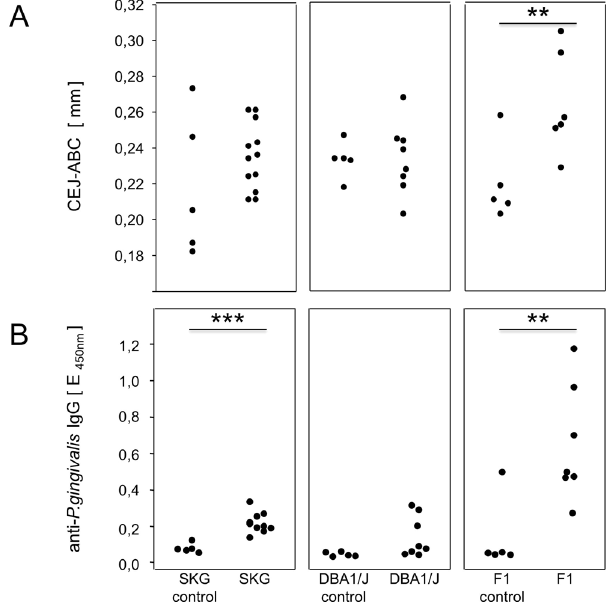
Figure 2. DBA/1J × B10.Q F1 mice were most susceptible to P. gingivalis ( Pg ) induced PD and anti- Pg antibody response. ( A ) Depicts the alveolar bone loss after PD induction by presenting the distance from the cementoenemal junction to the alveolar bone crest (CEJ-ABC) in millimeters of each individual mouse that was orally inoculated and their control mates. Assessment was performed by µ CT. ( B ) Shows the anti- P. gingivalis antibody titers comparing again individual mice that were orally inoculated to their untreated controls. Numbers of mice per group were SKG N = 10, DBA/1J N = 8, F1 (DBA/1J × B10.Q) N = 7, controls were N = 5 for each